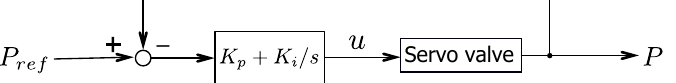
Figure 4. Block diagram of pneumatic pressure control. P ref and P (kPa) are reference pressure and current pressure respectively. K p (V/kPa) and K i (V/kPa s) are a proportional and an integral gains. u (V) is a control voltage, and s is a Laplace